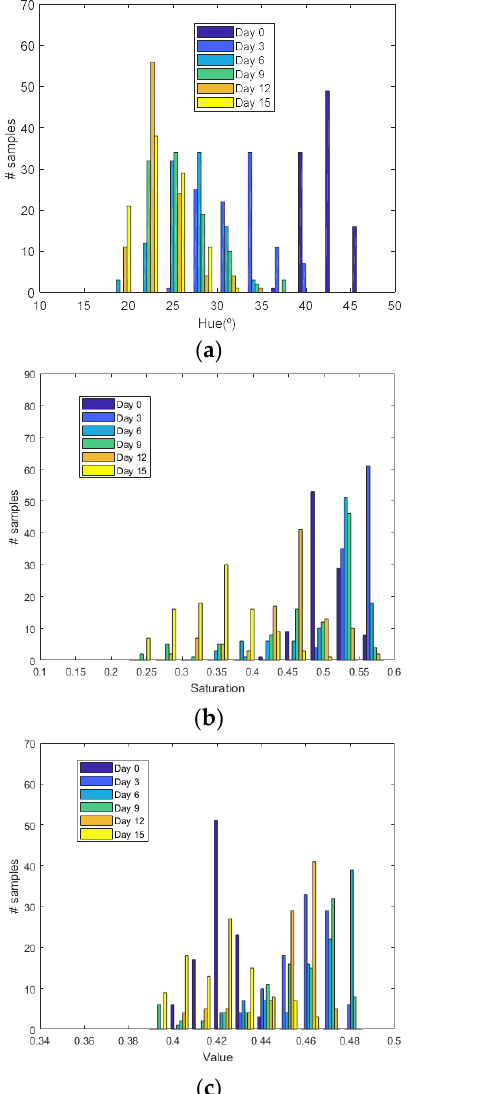
Figure 7. Cumulative Distribution Function (CDF) of the hue parameter for the golden apple in the fridge ( a ) and at room temperature ( b ) as a function of the number of days out of the fridge. Cumulative Distribution Function (CDF) of the saturation parameter for the golden apple in the fridge ( c ) and at room temperature ( d ) as a function of the number of days out of the fridge.